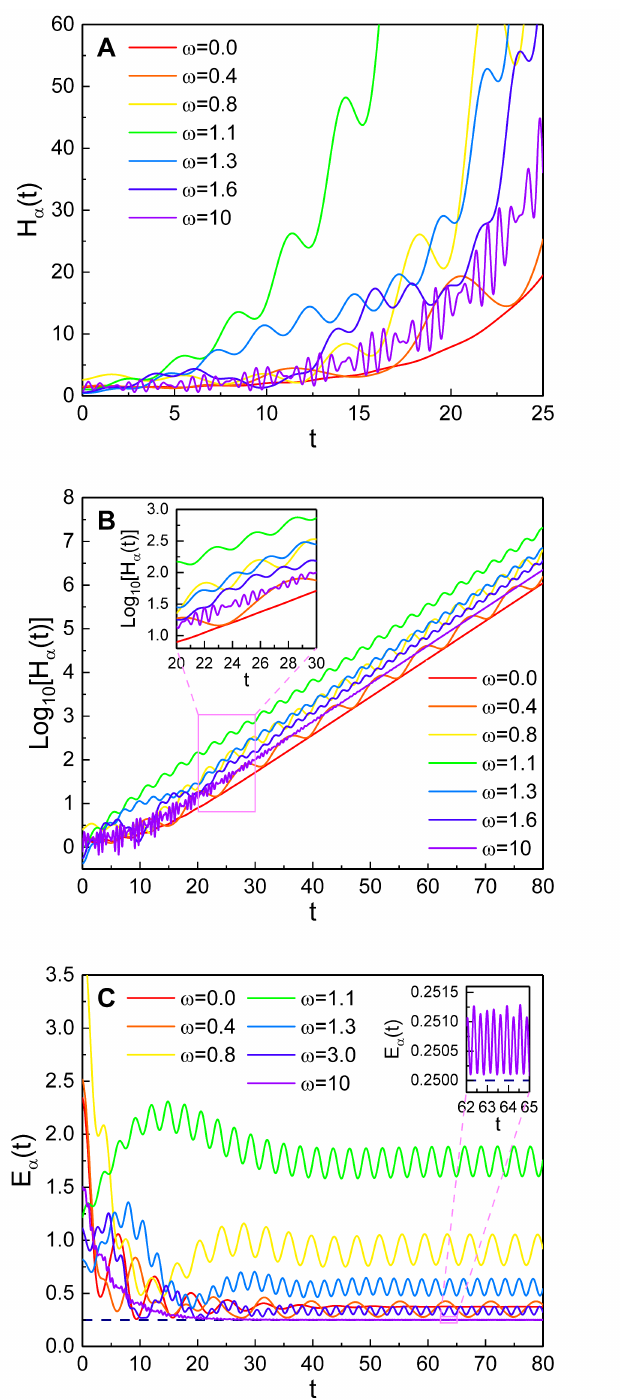
Figure 3. The effects of ω on the time evolution of H α ( A , B ) and E α ( C ). ( B ) is a log-scale graph for a relatively long time. The values that we have used are γ e = 0.2, ω e = 1, ϕ = 0, α 0 = 1, m = 1, ¯ h = 1, and f d =